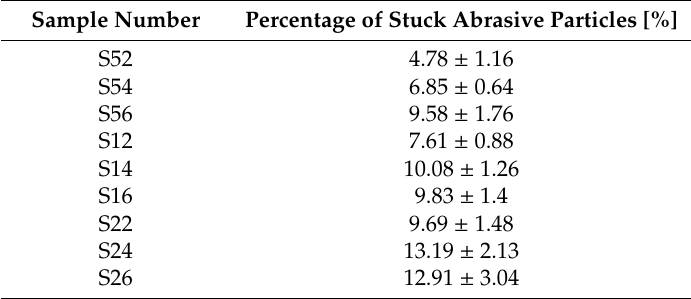
Table 6. The percentage of stuck abrasive particles on the